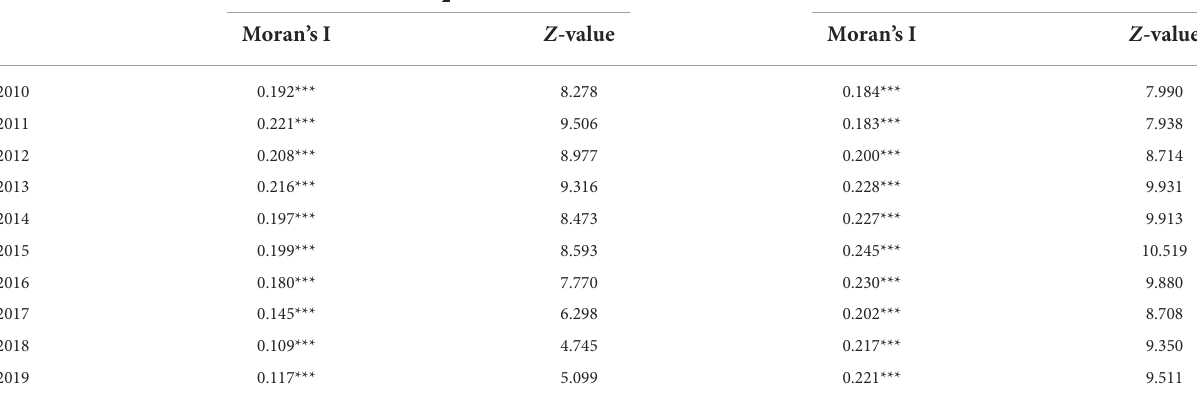
TABLE 8 Moran’s I index of lnso 2 and lnsmoke.